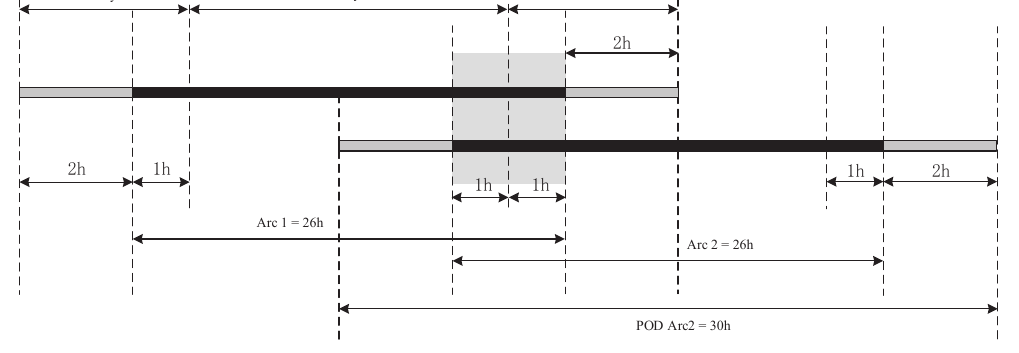
Figure 6. Overlapping arc diagram.